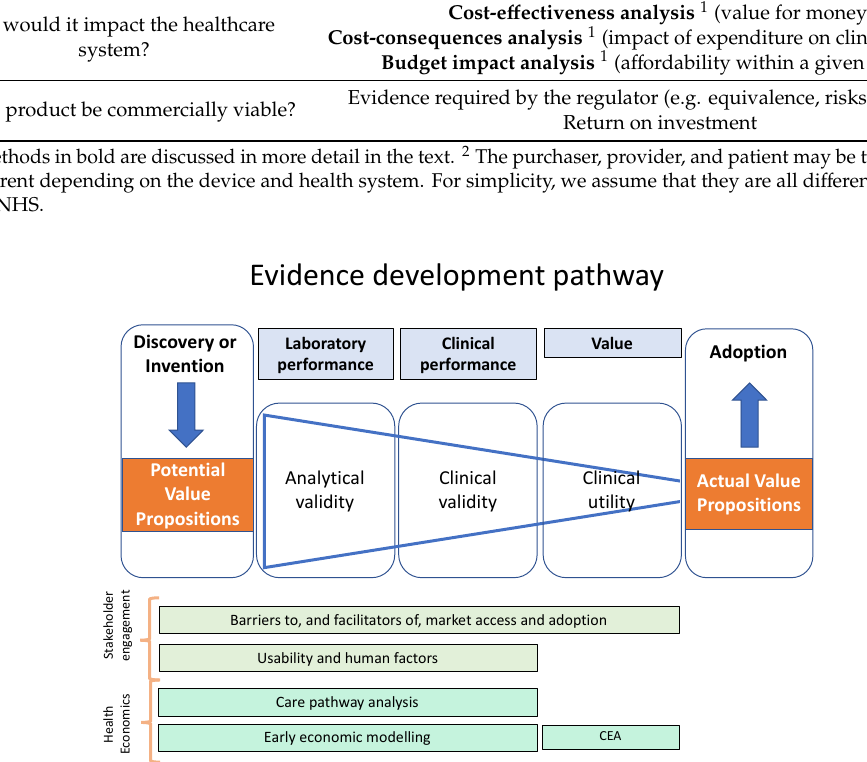
Figure 1. The pathway for developing evidence needed to support the adoption of a new POCT. CEA is Cost-Effectiveness Analysis. The steps are described in more detail in the following sections.